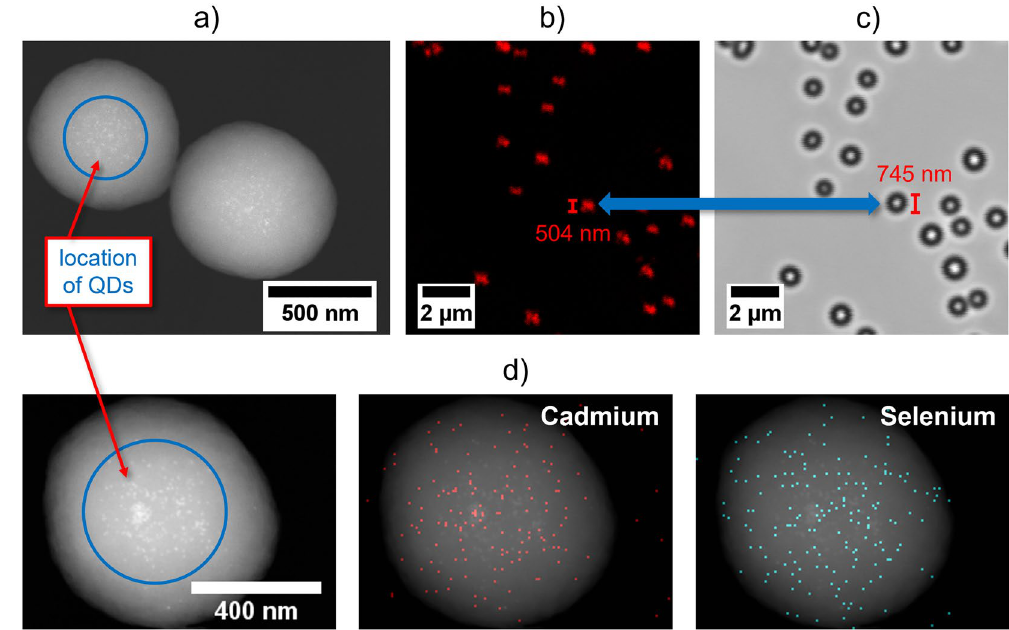
Figure 6. Localization of the QDs inside the PS microbeads, determined ( a ) with a STEM image of DVB- crosslinked PS microbeads encoded with OBDAC-coated, OA/OLA-stabilized CdSe/CdS-QDs, revealing the location of the QDs in the microbead core region; with CLSM images of the same particles measured ( b ) in fluorescence and ( c ) in transmission, including a size comparison of the fluorescent area and the particle diameter derived from the transmission image and ( d ) with EDXS analysis of the same DVB-crosslinked PS microbeads encoded with OBDAC-coated, OA/OLA-stabilized CdSe/CdS-QDs. Reaction conditions of